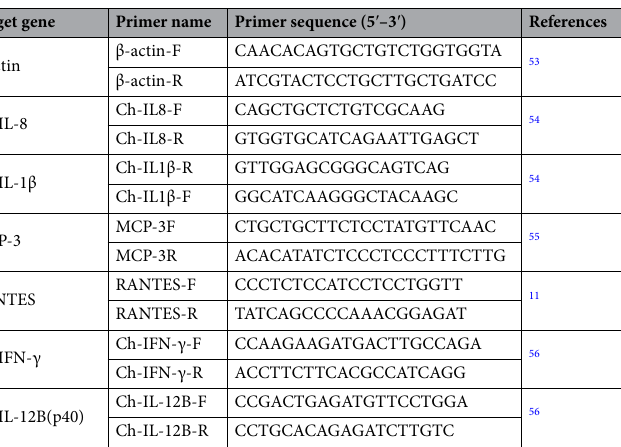
Table 3. Target genes and primer sequences used for quantitative RT-PCR in this study. Ch-IL Chicken interleukin, MCP-3 monocyte chemotactic protein 3, RANTES regulated on activation, normal T cell expressed and secreted, IFN-γ